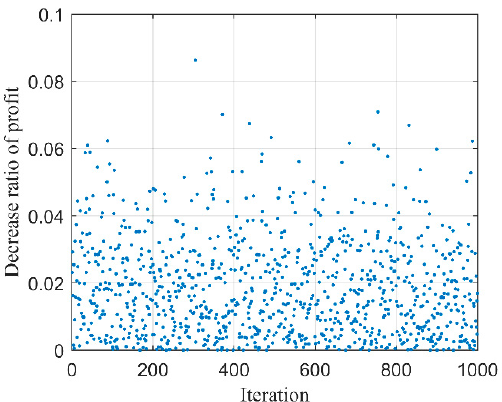
Figure 3. Profit comparison results of the MTCBAA and the artificial immune algorithm.